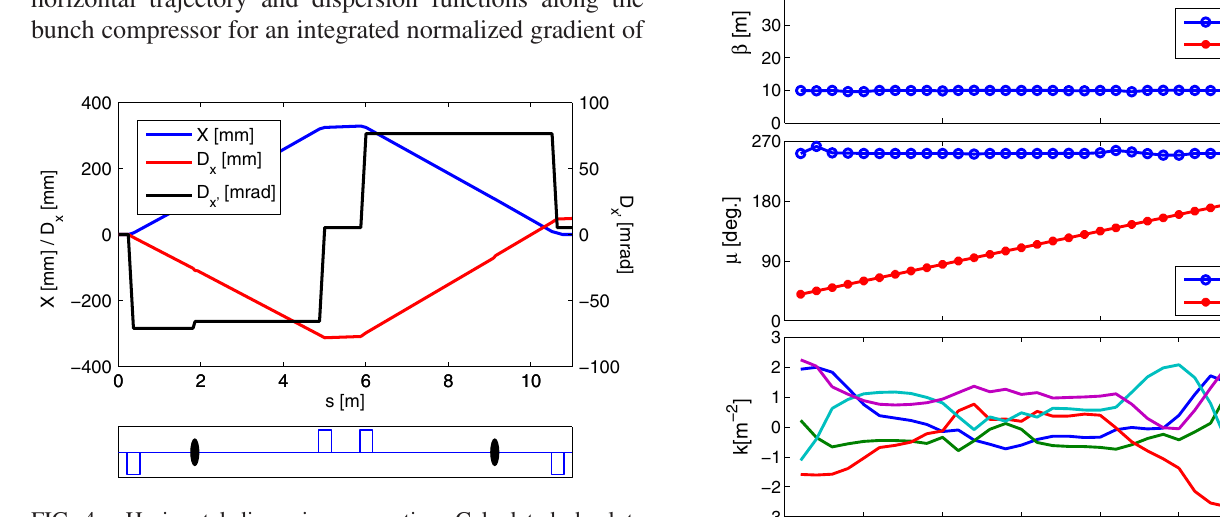
FIG. 5. Scan parameters for the vertical slice-emittance meas- urement: β -functions at the measurement position (upper plot), phase advances (middle plot), and quadrupole strengths (lower plot) as a function of the scan